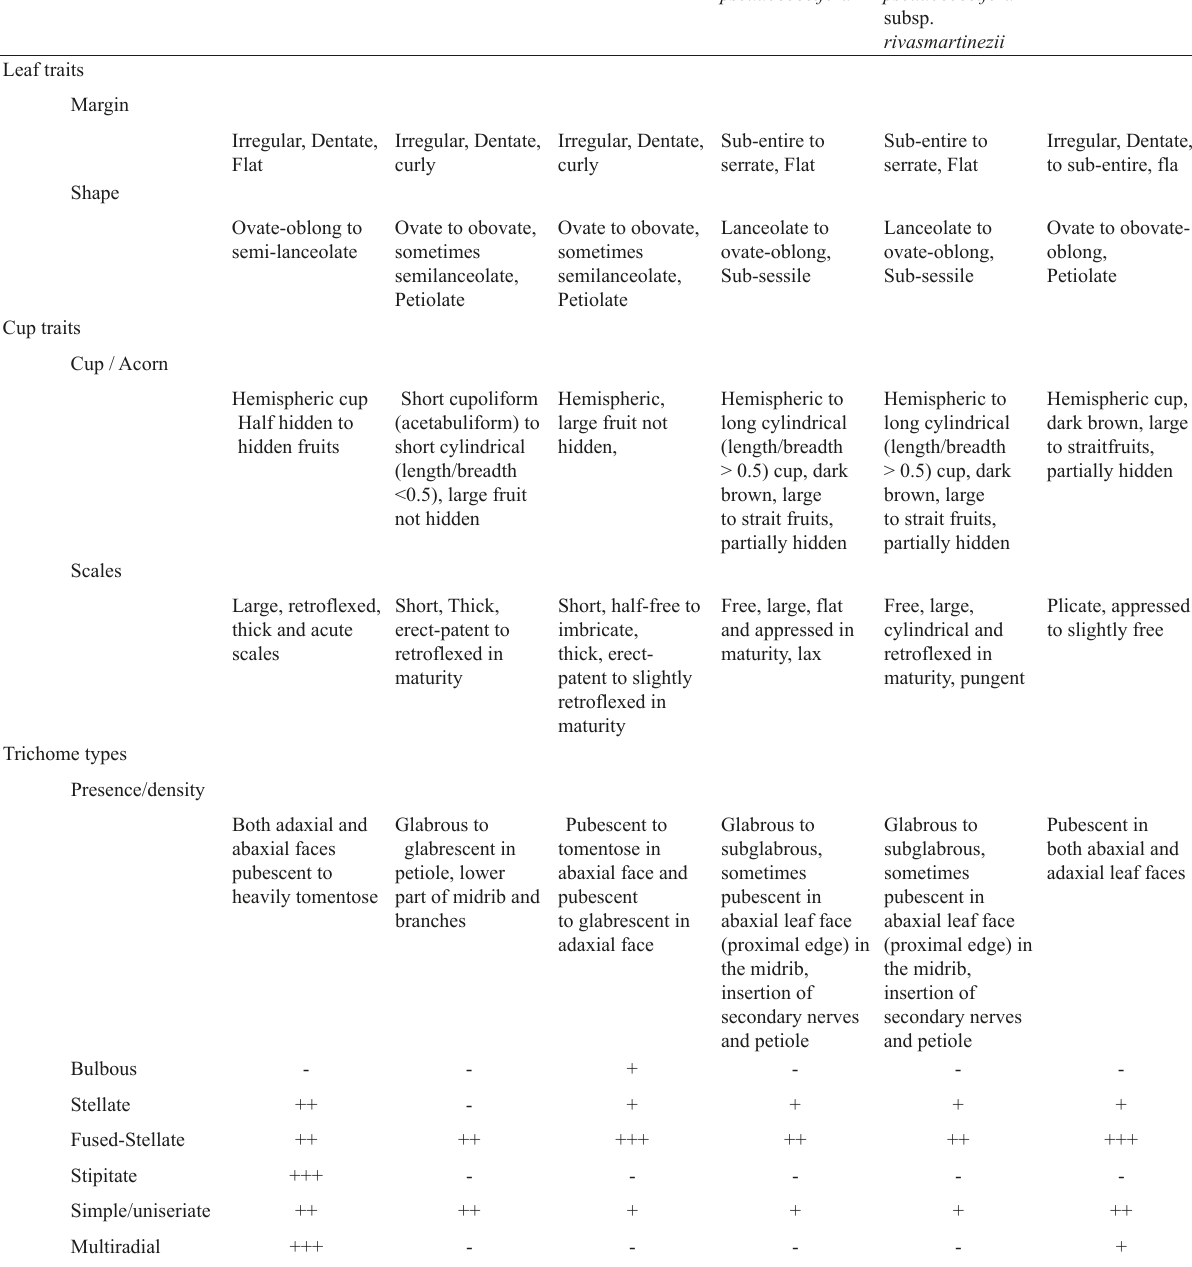
Table 1. Synthetic table of the differential characters for the western Mediterranean kermes oaks and related nothotaxa. Species/